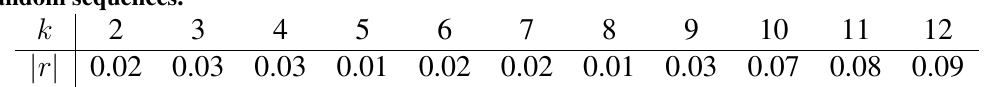
Table 3: Pearson’s correlation coefficient between sequence length and VR values for all generated random